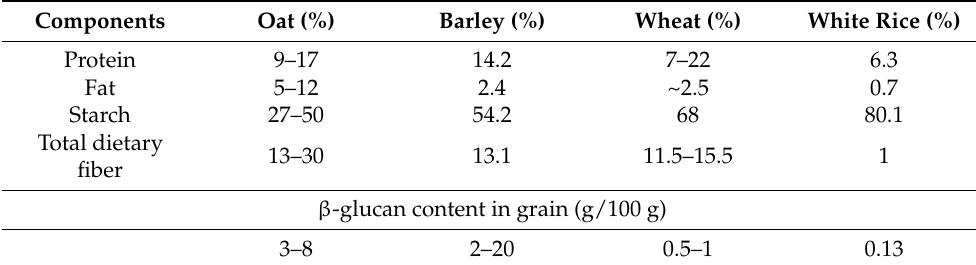
Table 1. Comparison in the functional components in white rice, wheat, oat, and barley [18]. Components Oat (%) Barley (%) Wheat (%) White Rice (%)